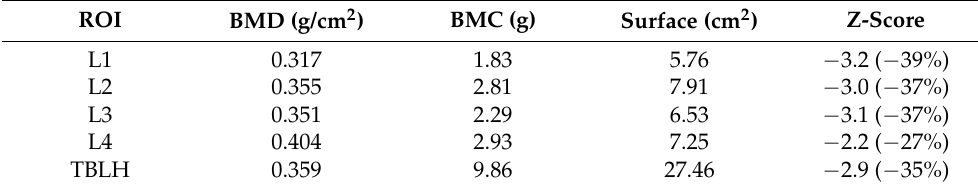
Table 1. The results of DXA conduced on 13 July 2020.